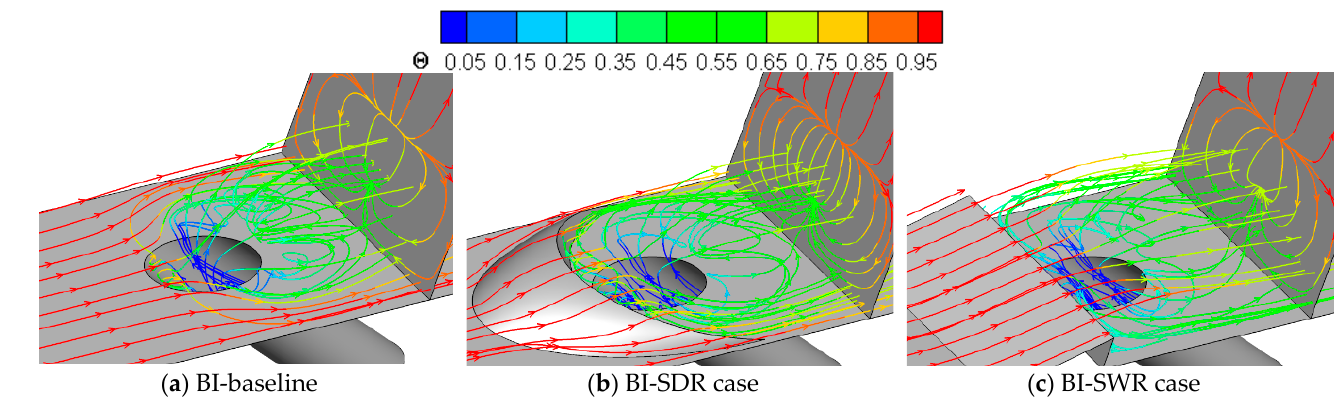
Figure 6. Local streamlines colored by the dimensionless temperature in BI cases.